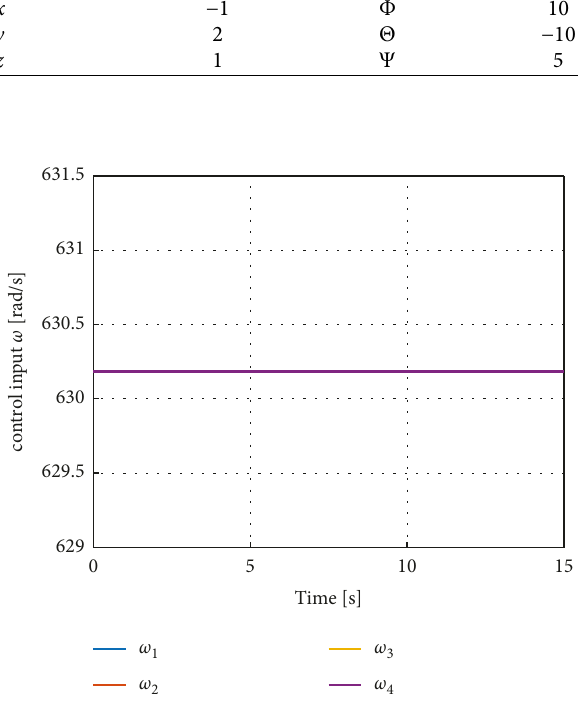
Figure 4: Control inputs for the angular velocities of the